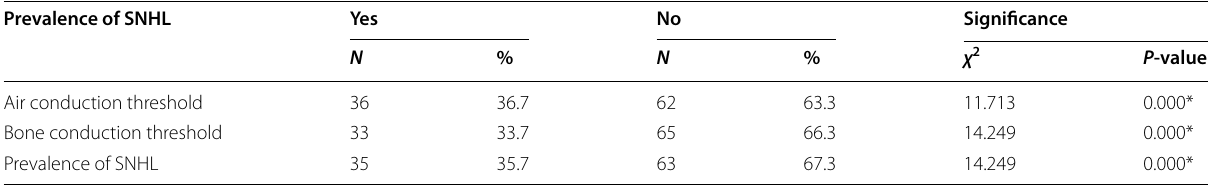
Table 5 Prevalence of SNHL in SLE patients ( N